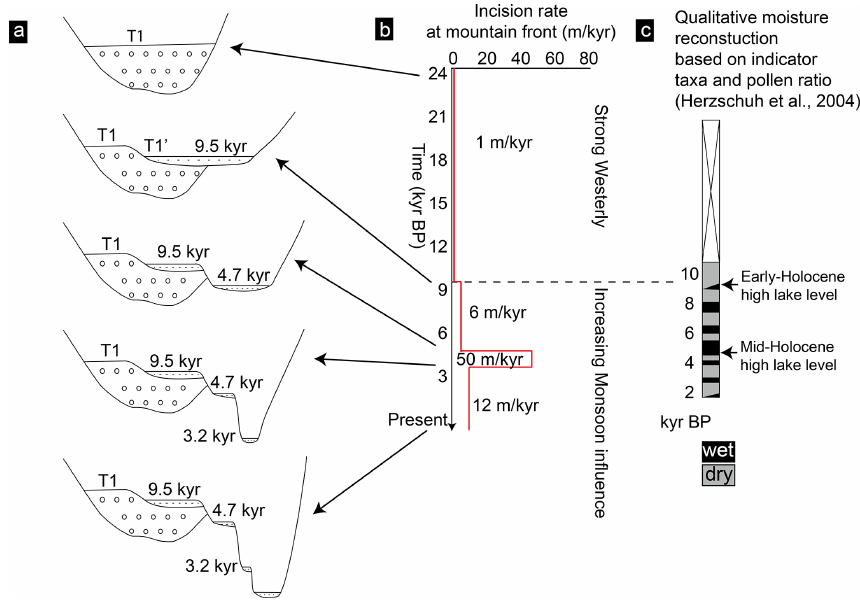
Figure 9. (a) Schematic cross sections of Beida River channel evolution at the mountain front. (b) Diagram of incision rate vs. time since 24kyrBP. (c) Climate reconstruction based on the Eastern Juyanze paleolake record (Herzschuh et al.,